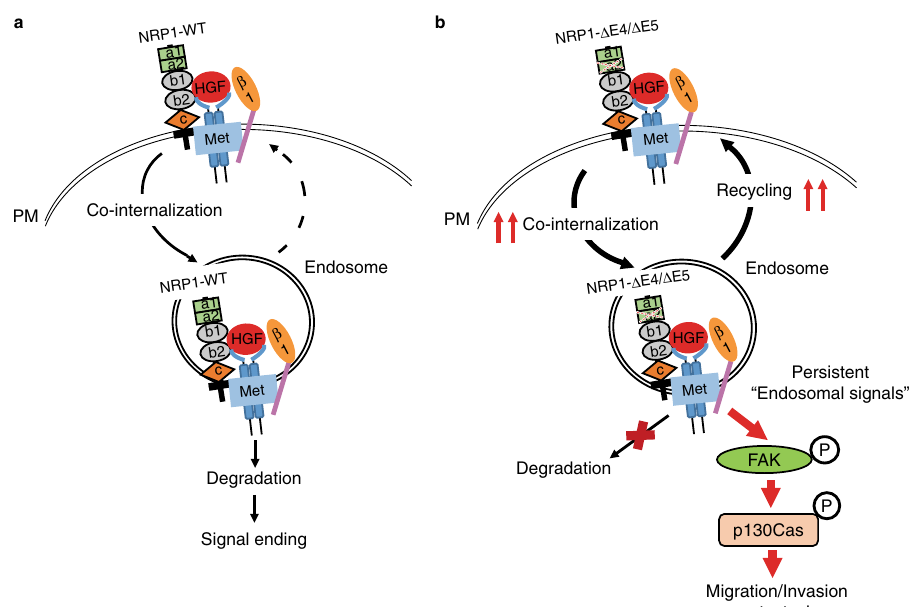
Fig. 9 A model for NRP1-WT and its splice variants signaling in CRC cell dissemination. a NRP1-WT associates with Met and β 1-integrin receptors and resides on plasma membrane (PM) under basal conditions, and internalizes upon stimulation by HGF followed by rapid degradation, leading to a restricted period of signal generation. b NRP1- Δ E4 or NRP1- Δ E5 renders Met and β 1-integrin co-internalization and constitutively recycles back to the cell surface or the extracellular space under basal conditions. These events result in an increased accumulation of the NRP1 variants/Met/ β 1-integrin complexes on endosomes, which provides persistent endosomal signals to activate the FAK/p130Cas pathway for promoting cell migration, invasion and metastasis in CRC. These oncogenic activities of NRP1- Δ E4 or NRP1- Δ E5 are further enhanced by HGF